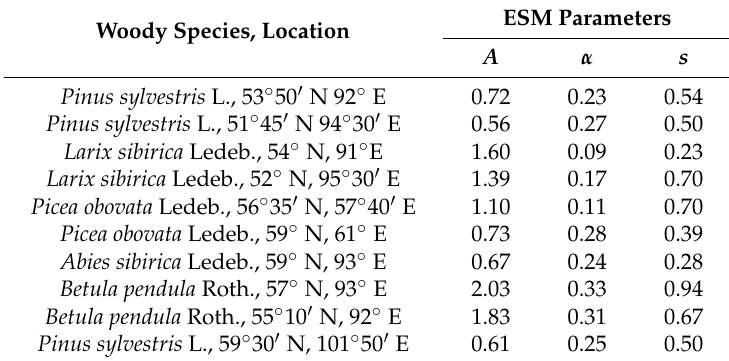
Table 2. ESM parameters for forest stands with different woody species in Siberia [10,11]. Woody Species,